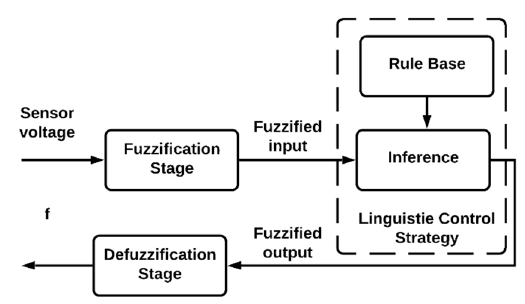
Figure 8. Structure of fuzzy logic algorithm for SD calculation.